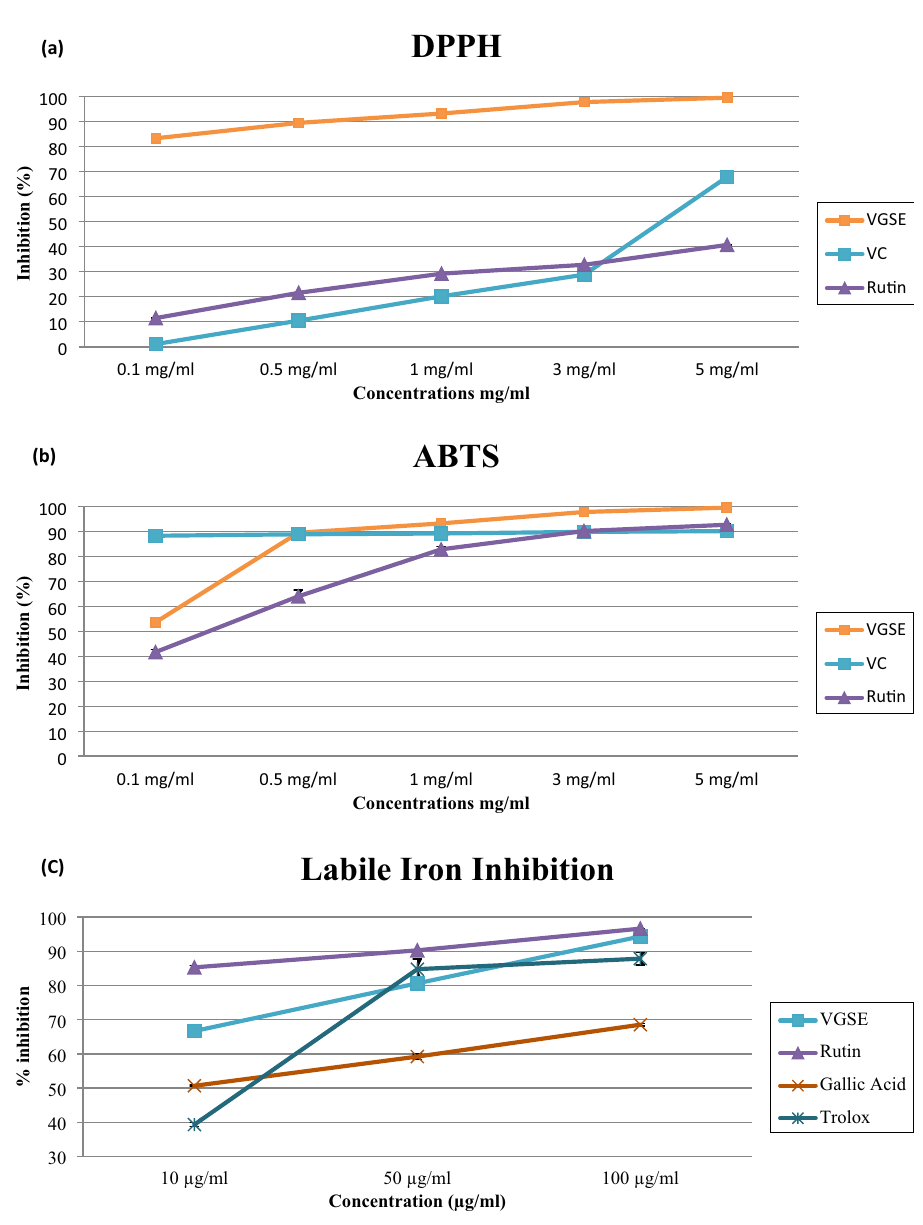
Figure 1. Free radical inhibition activities of VGSE or antioxidant compounds at different concentrations; ( a ) DPPH · inhibition activity, ( b ) ABTS · inhibition activity, and ( c ) Labile iron inhibition activity; Values are means ± SD of three